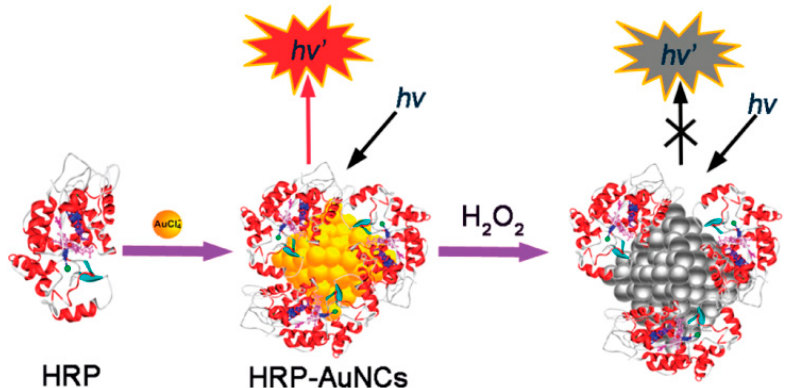
Figure 6. Schematic of the formation and the H 2 O 2 directed quenching of horseradish peroxidase (HRP)-protected AuNCs. Adapted with permission from Reference [63] Copyright (2011) American Chemistry Society.